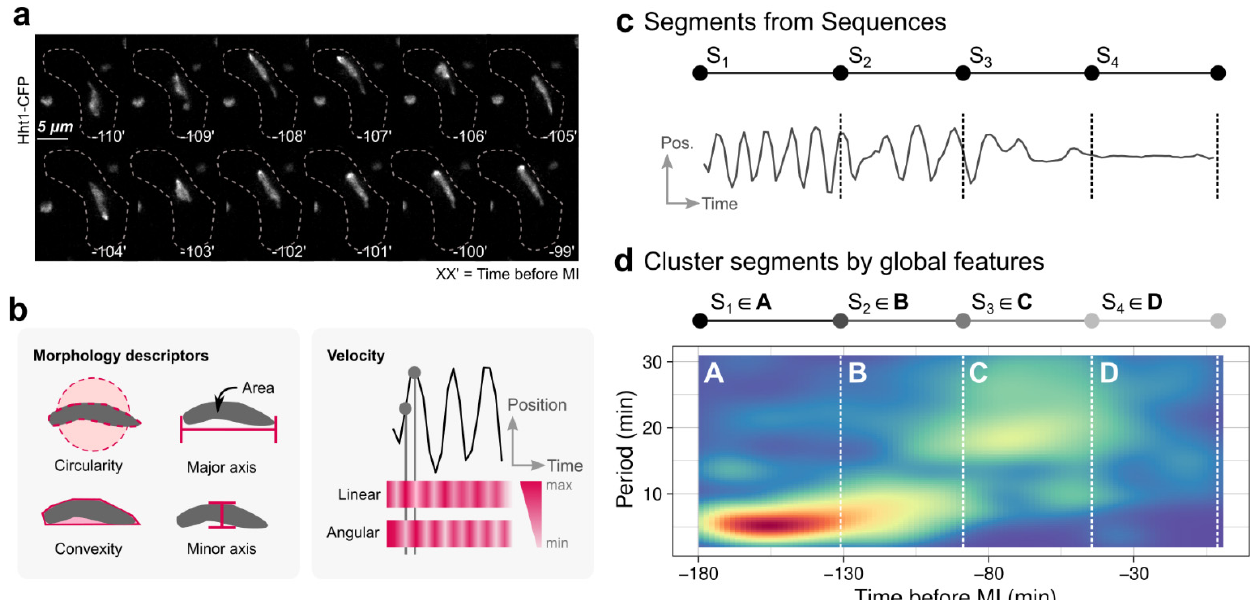
Figure 1. ChroMo analysis of chromosome movements in S. pombe wild-type settings during meiotic prophase. ( a ) Series of frames of film of a wt meiocyte harbouring Hht1-CFP (histone H3 tagged at one of the two endogenous hht1 + loci; chromosomes). Numbering indicates meiotic progression in minutes, t = 0 being just before meiosis I. ( b ) Morphology descriptors—area, circularity, convexity, major and minor axes—as well as linear and angular velocities, are calculated from the chromosome signal of each individually recorded cells. ( c ) An individual example segmentation according to movement of the chromosome mass, described by its angular and linear velocities, is presented. ( d ) Once various individual cells have been segmented, clustering is applied to find relevant groupings of segments that may explain a conserved behaviour. This can be further checked by visualizing the average behaviour of, e.g., the spectrogram (depicted below) of all retrieved sequences standardized in time by the beginning of MI.